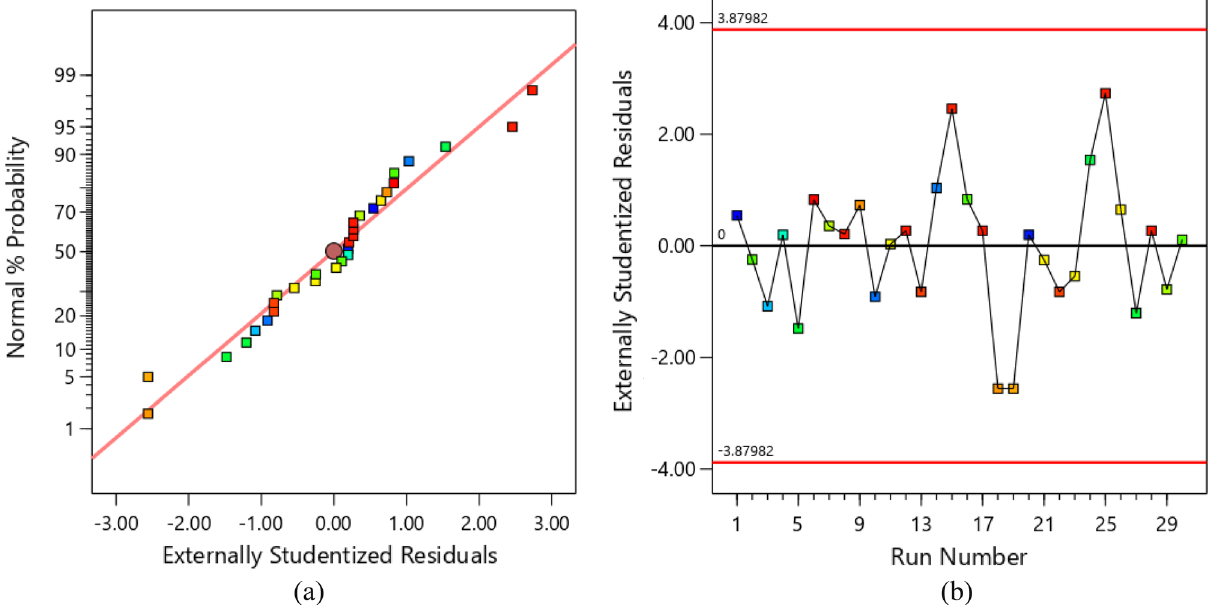
Figure 5. The normal plot of residuals ( a ), the plot of residuals versus run number for removal of Cd(II) ( b